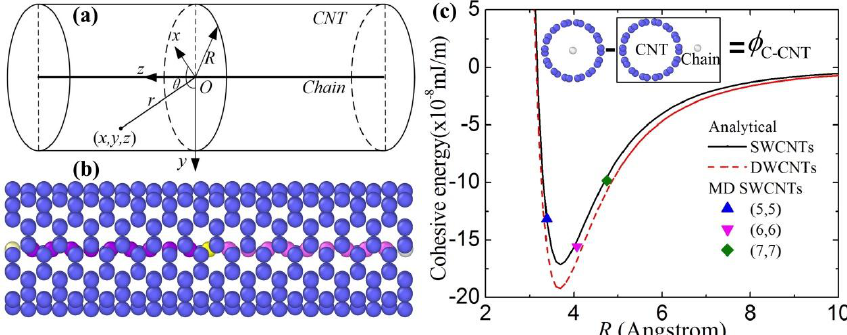
Figure 1. A coordinate system and a schematic diagram as well as cohesive energy of a carbon chain in an SWCNT. ( a ) The coordinate system and the schematic diagram. ( b ) The atomic structures of a carbon chain in a (5,5) CNT. ( c ) The cohesive energy of a carbon chain in different SWCNTs and DWCNTs using continuum modeling and MD simulations.